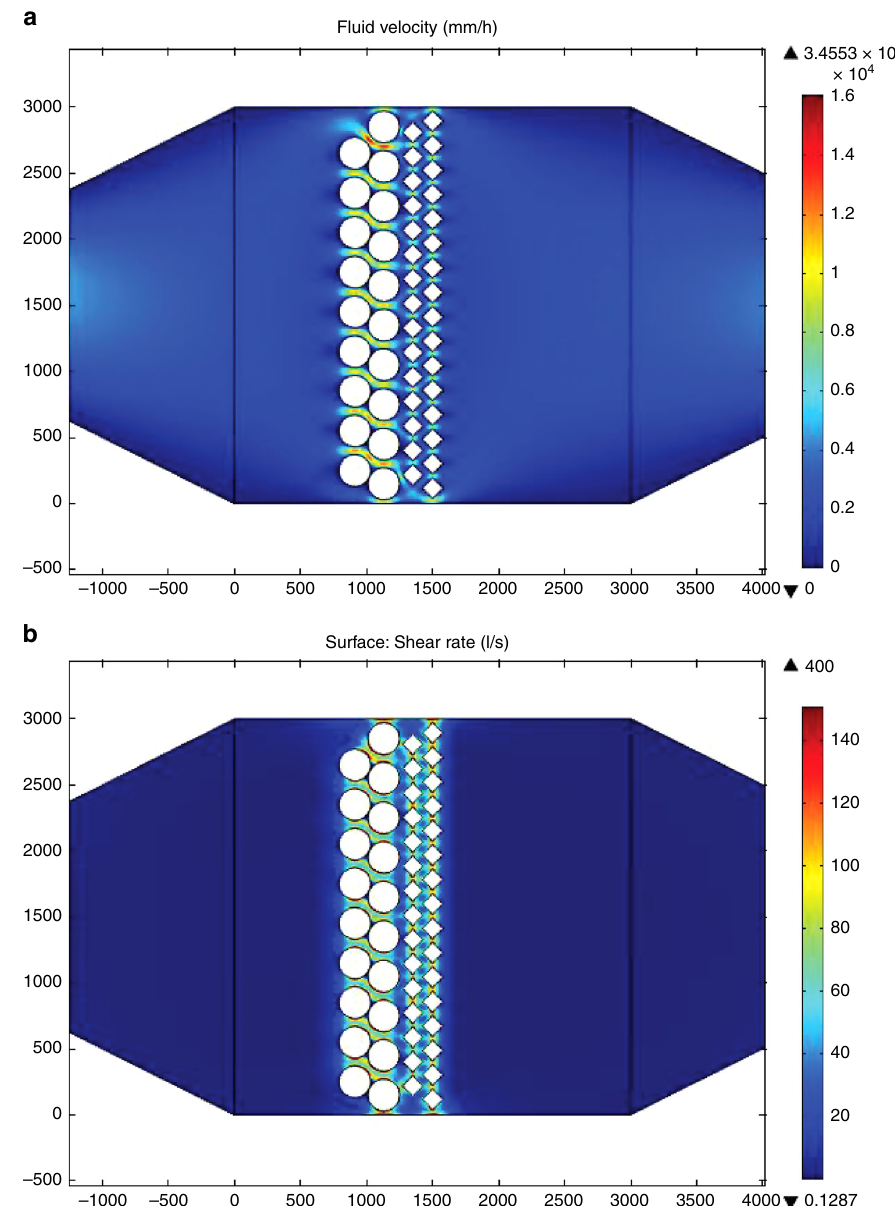
Fig. 5 Modulation of the fl ow and shear rate inside the oviduct-on-a-chip. In a notice the evenly distributed fl ow, that is direct and increases between pillars and “ COCs/embryos ” (white circles), mimicking IVF simultaneous with perfusion of the apical compartment. In b simulation of shear rate, note that embryos between the pillars and other embryos experience a higher shear